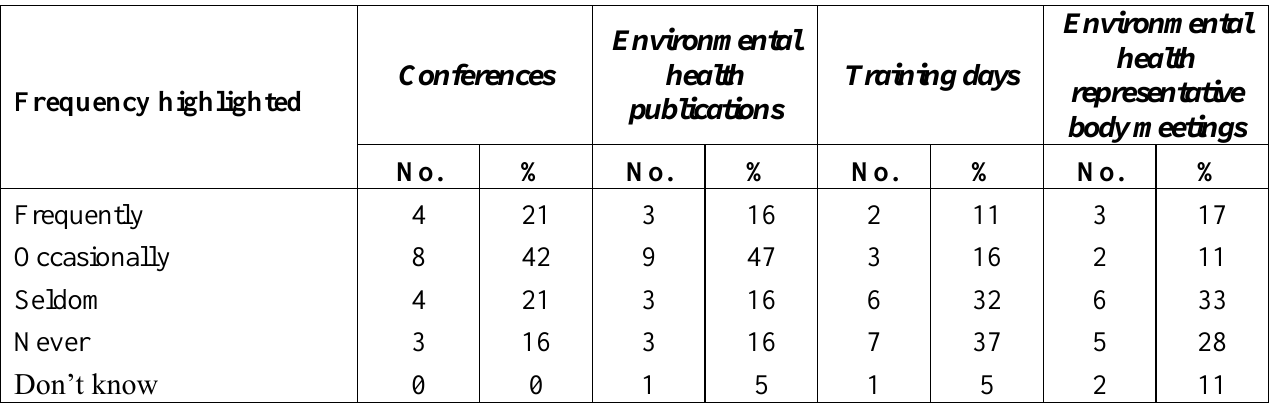
Table 3. Frequency Tobacco Issues Highlighted by IFEH